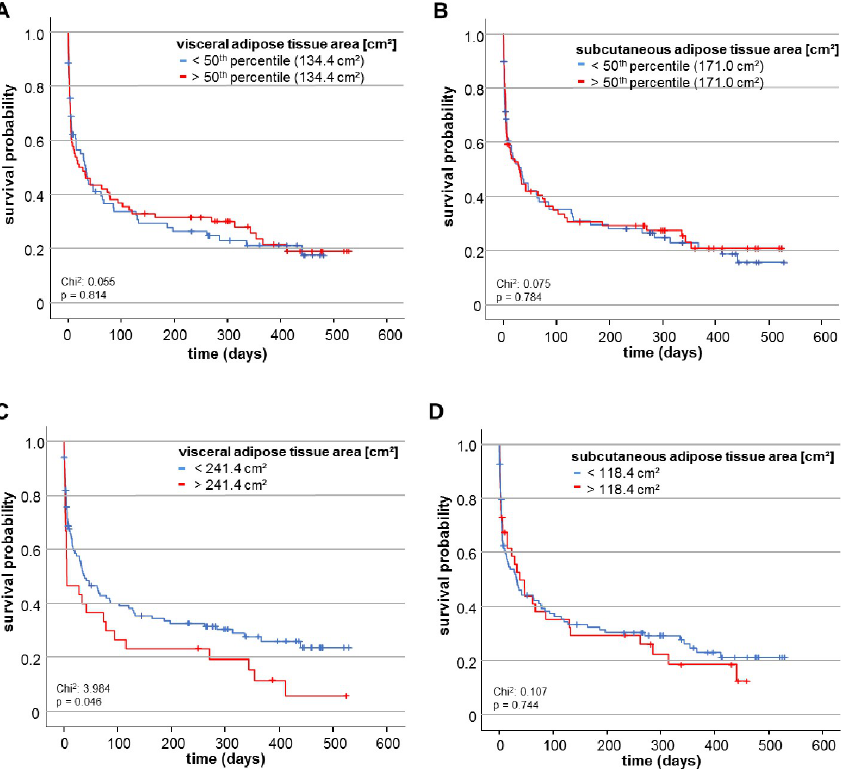
Fig 6. The VAT area predicts overall survival in critically ill patients. (A, B) When using the median of both adipose tissue areas as cut-off values, neither the VAT nor the SAT area cut-off value predicts overall survival as Kaplan Meier curve analysis reveals. (C) Using the optimal cut-off value, patients with a VAT area below 241.4 cm 2 show an improved overall survival. (D) In contrast to the VAT area, the optimal cut-off value of the SAT area does not differ between overall survivors and